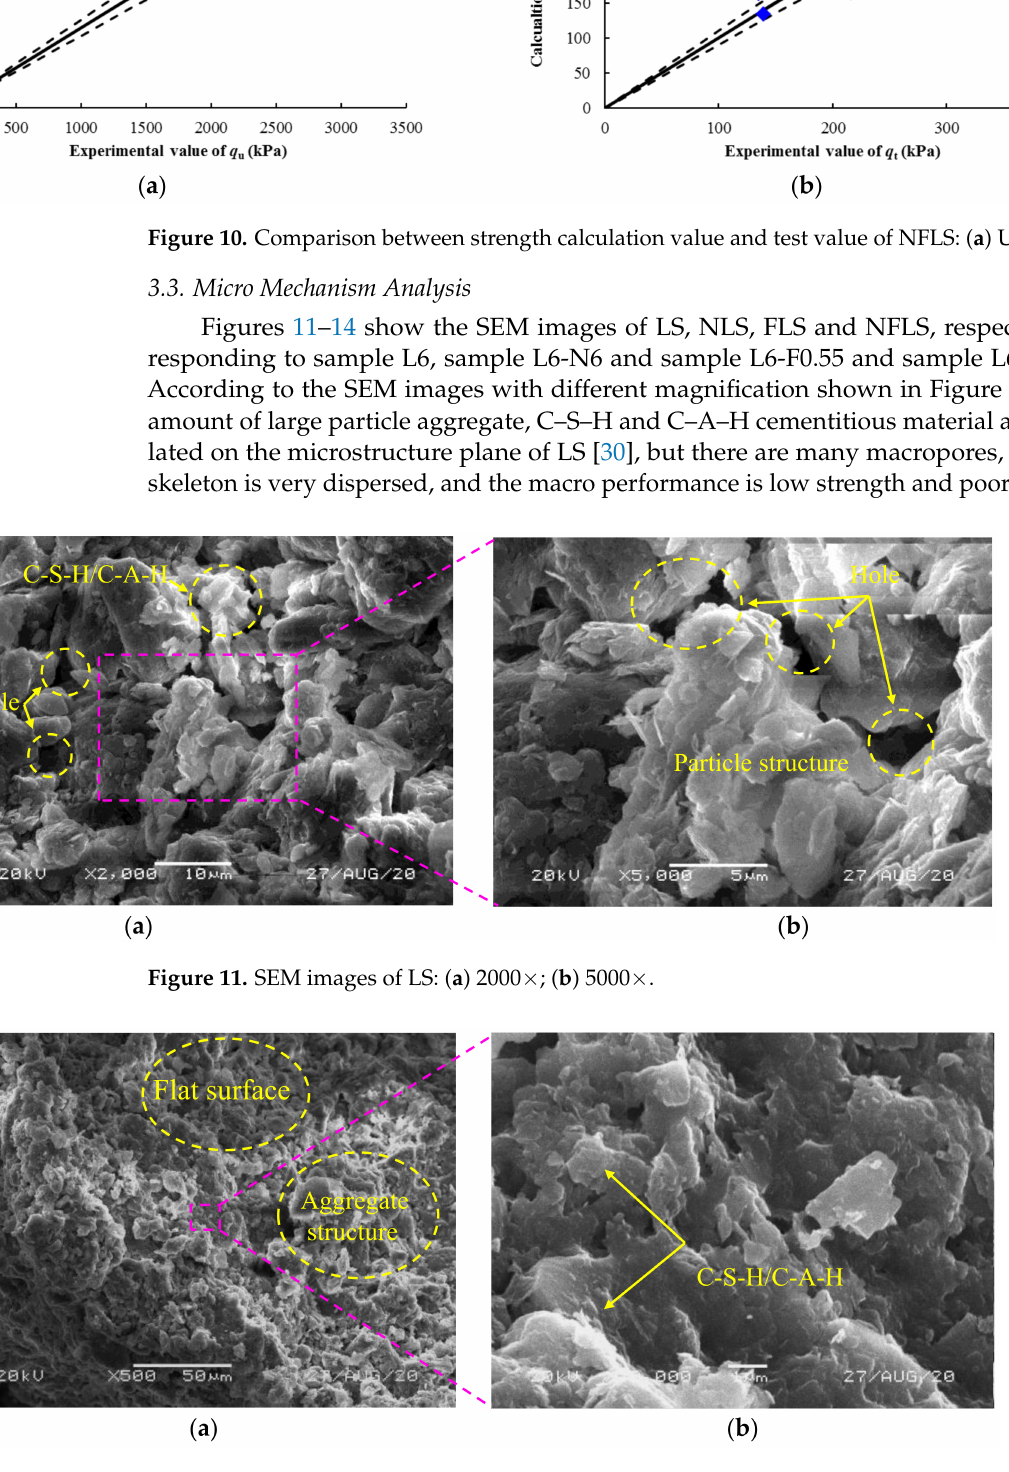
Figure 12. SEM images of NLS: ( a ) 500 × ; ( b ) 2000 ×